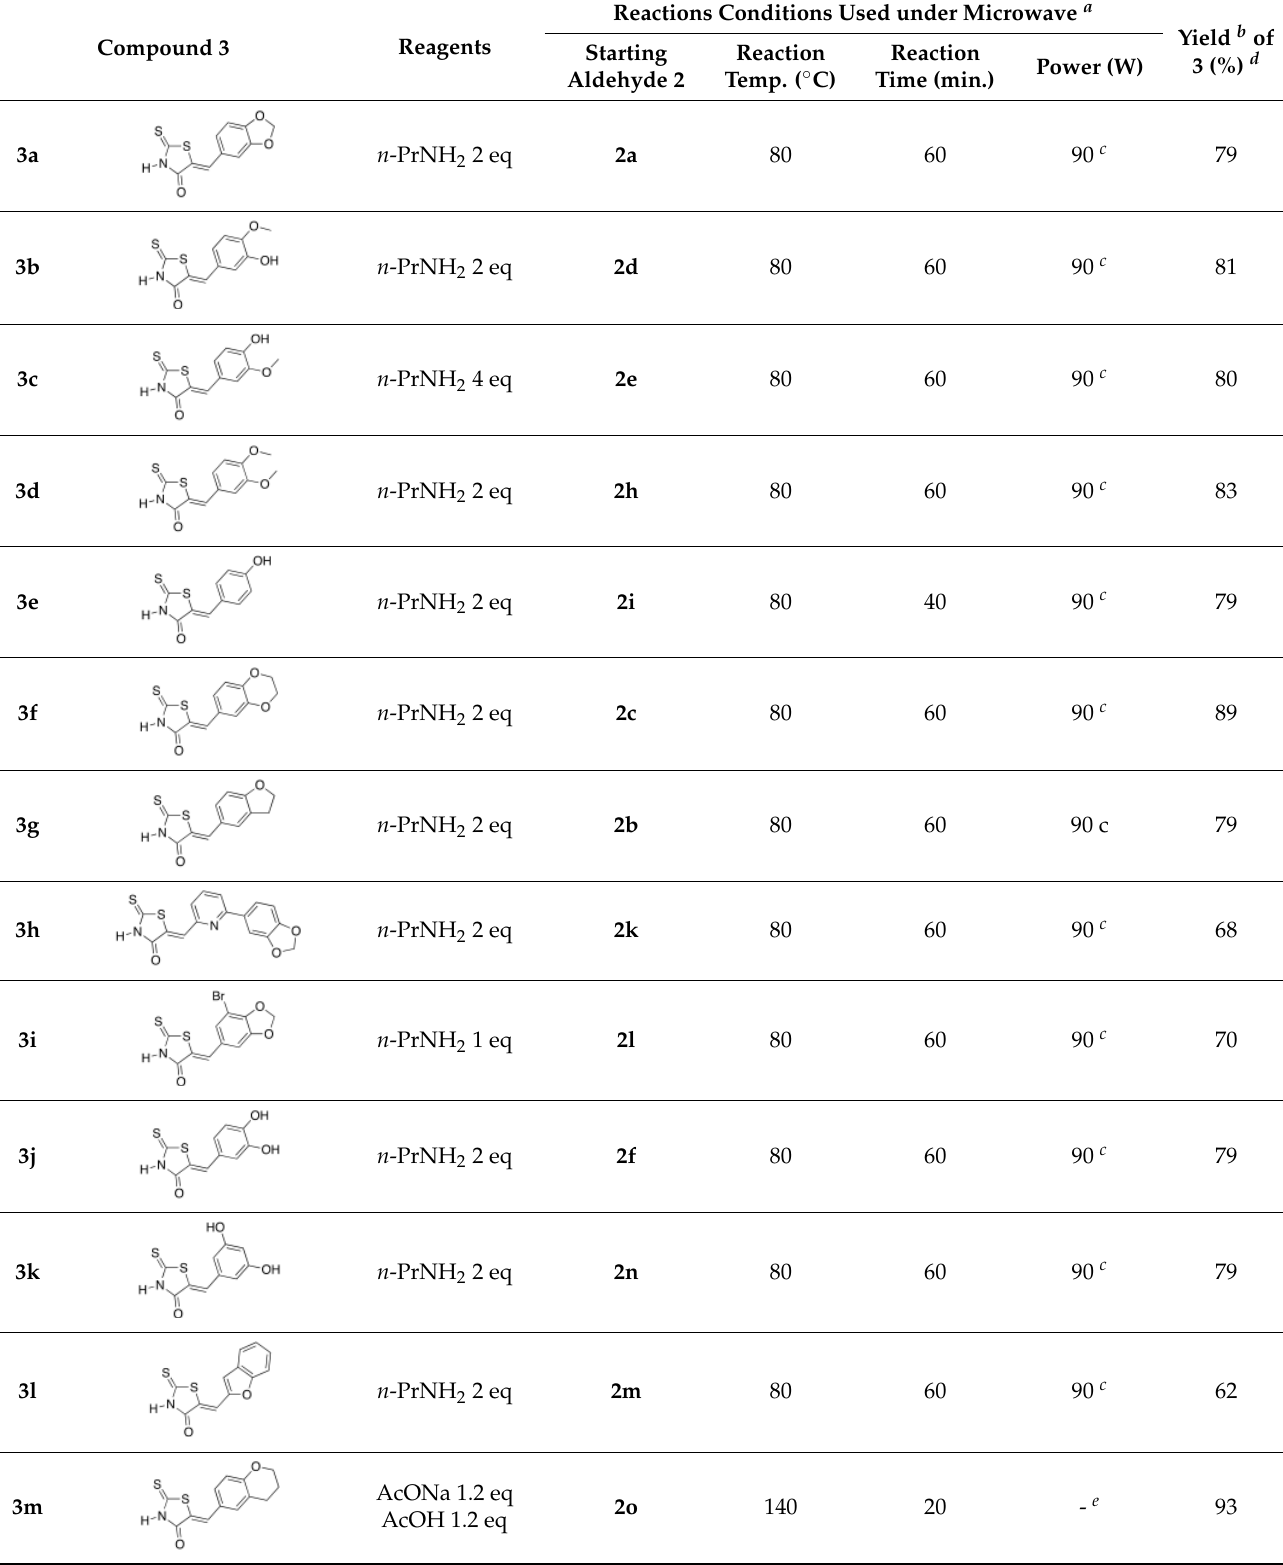
Table 1. Results for the preparation under microwave irradiation of (5 Z ) 5-arylidene-2-thioxo-1,3-thiazolidin-4-one